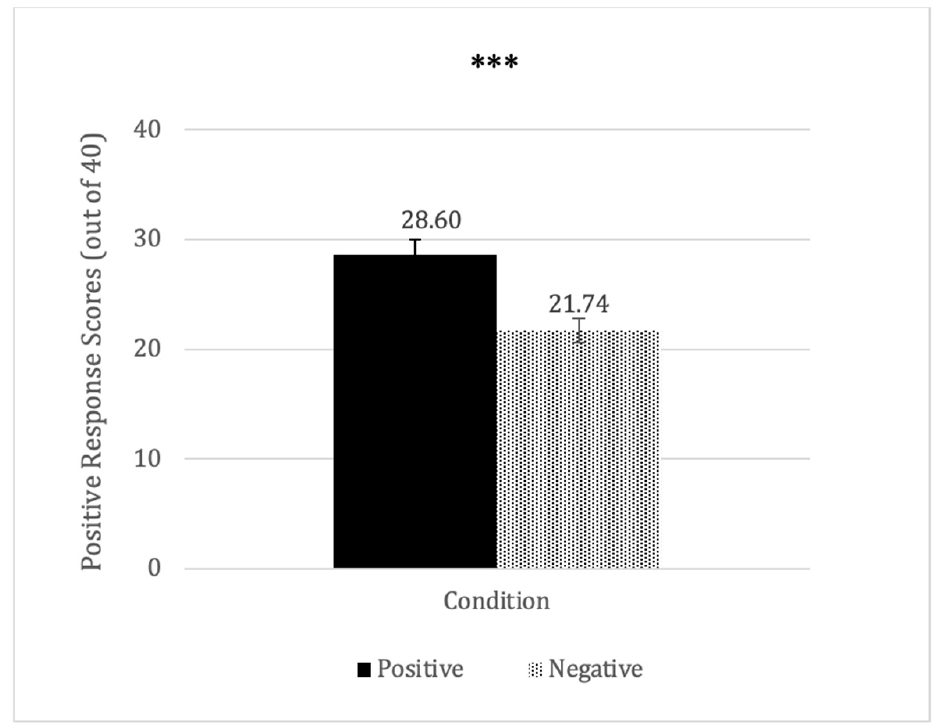
Figure 1. Positive response scores by condition. *** p < 0.001.